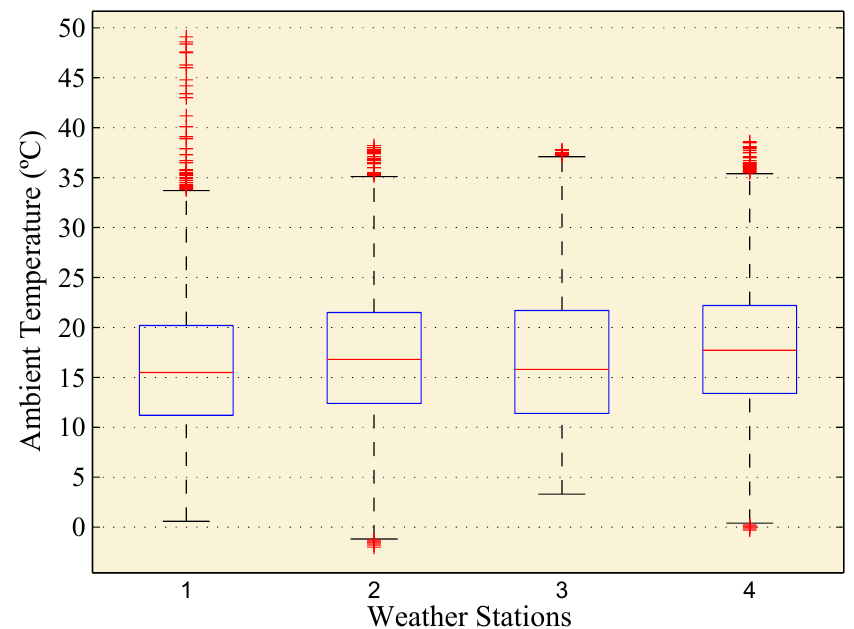
Figure 3. Box plot of ambient temperature for all weather stations along the line.